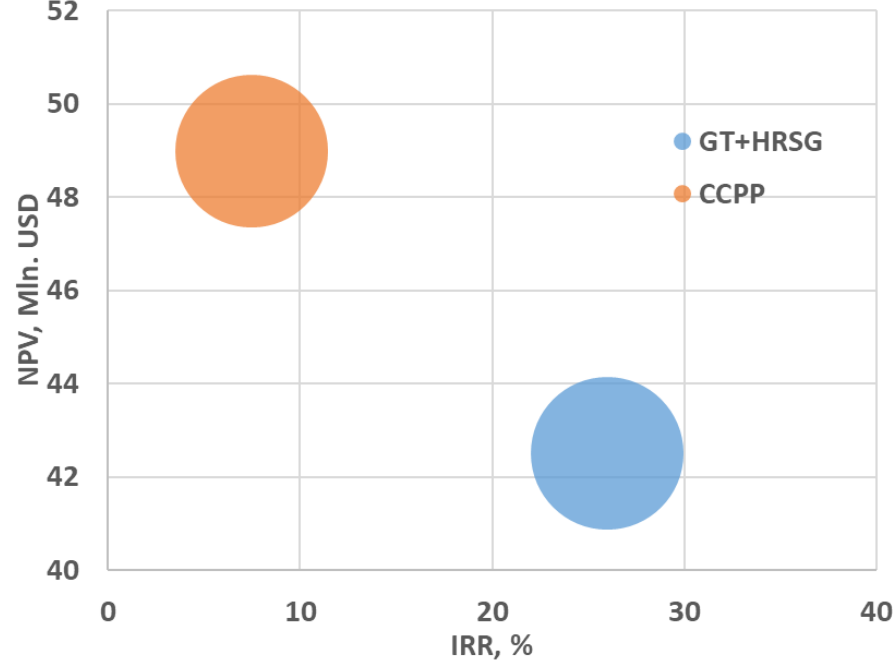
20 of 25 Table 5. Basic data for economic calculation. Parameter